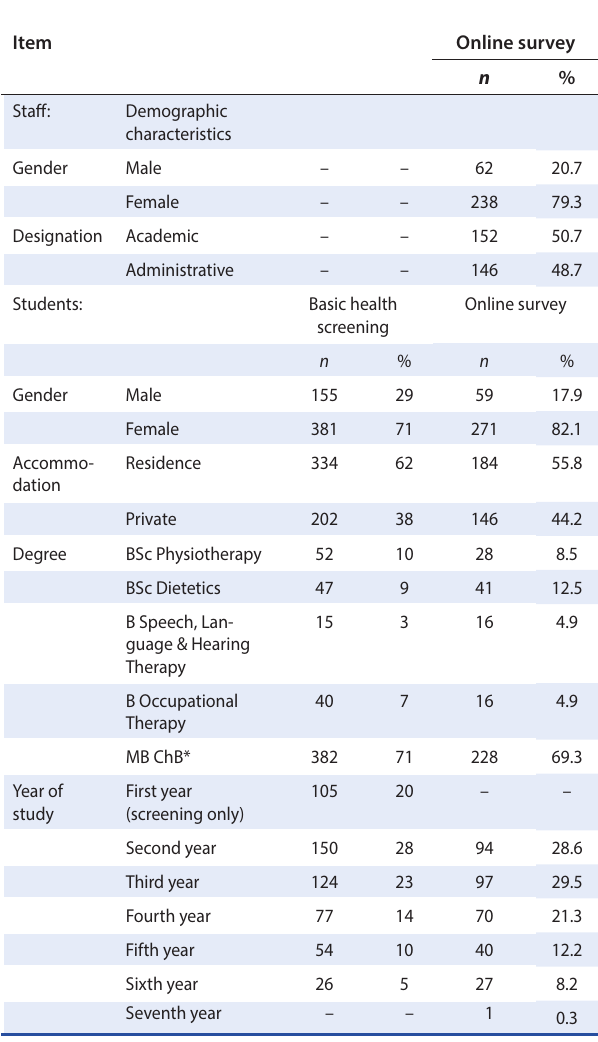
Two participants did not indicate staff designation. *MBChB = Bachelor of Medicine and